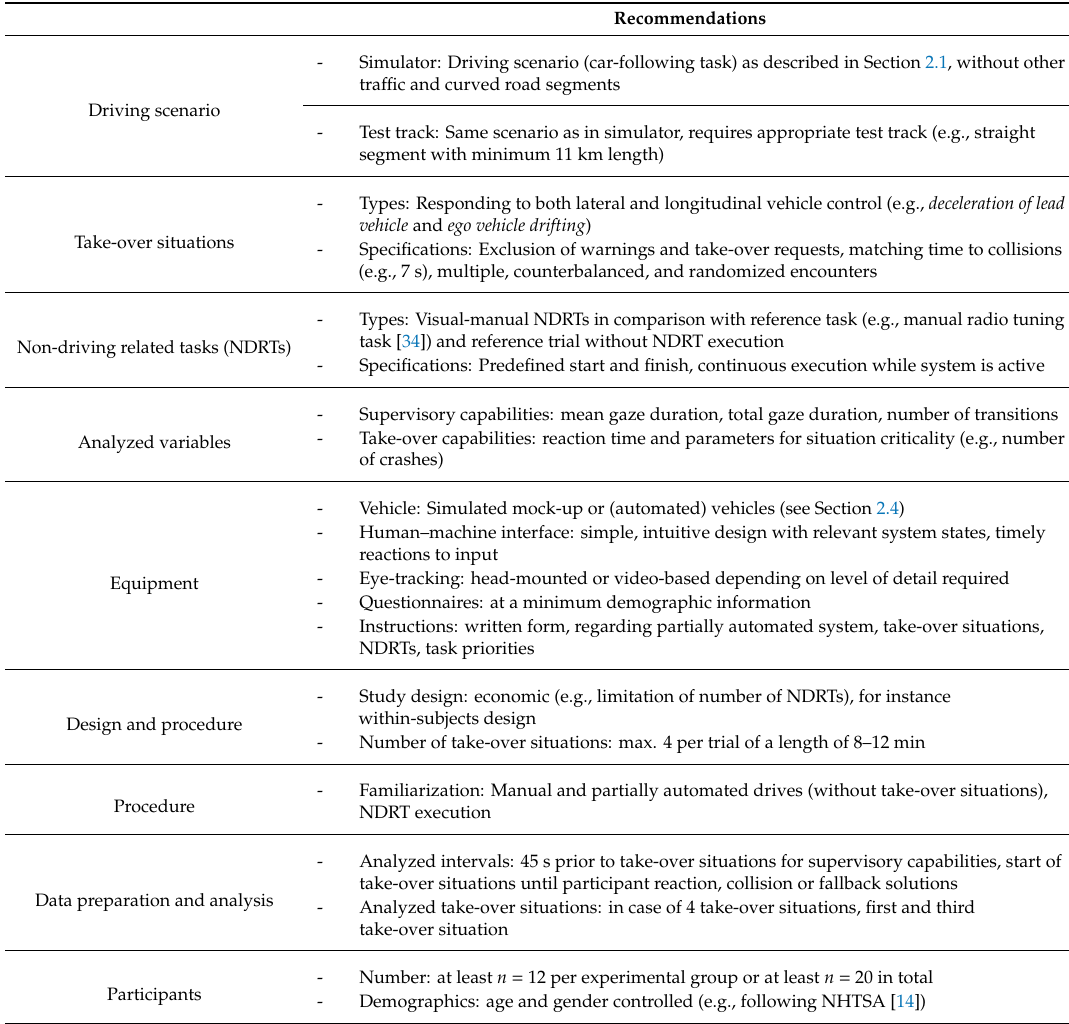
Table 6. Short summary of the recommendations for test protocol